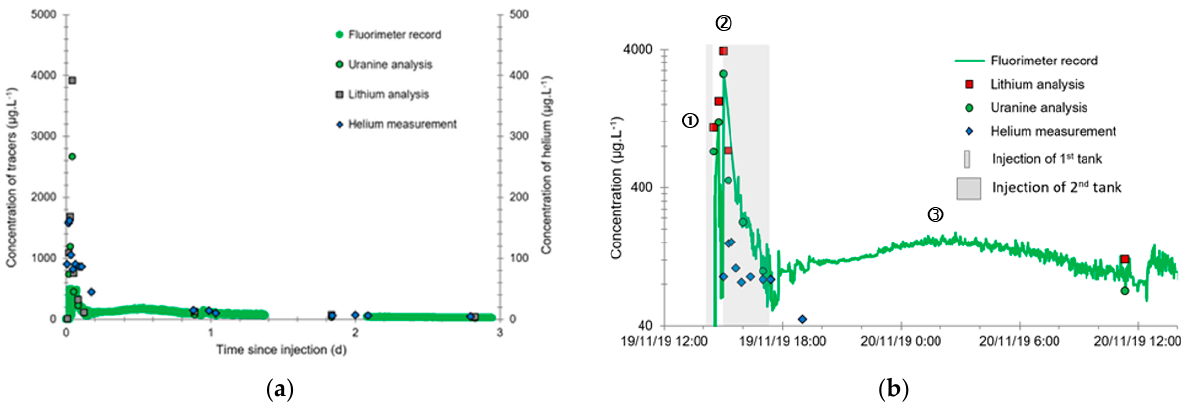
Figure 10. Breakthrough curves for the tracers at PZ2BIS (5 m downstream): ( a ) during the first three days of monitoring; and ( b ) detail of the first day of monitoring.